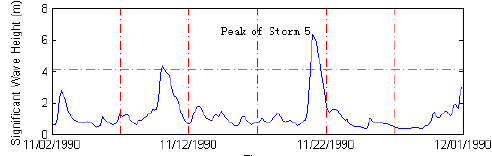
Figure 3. Time series significant wave heights of location S1 in a 720-hour period, covering storm 5.